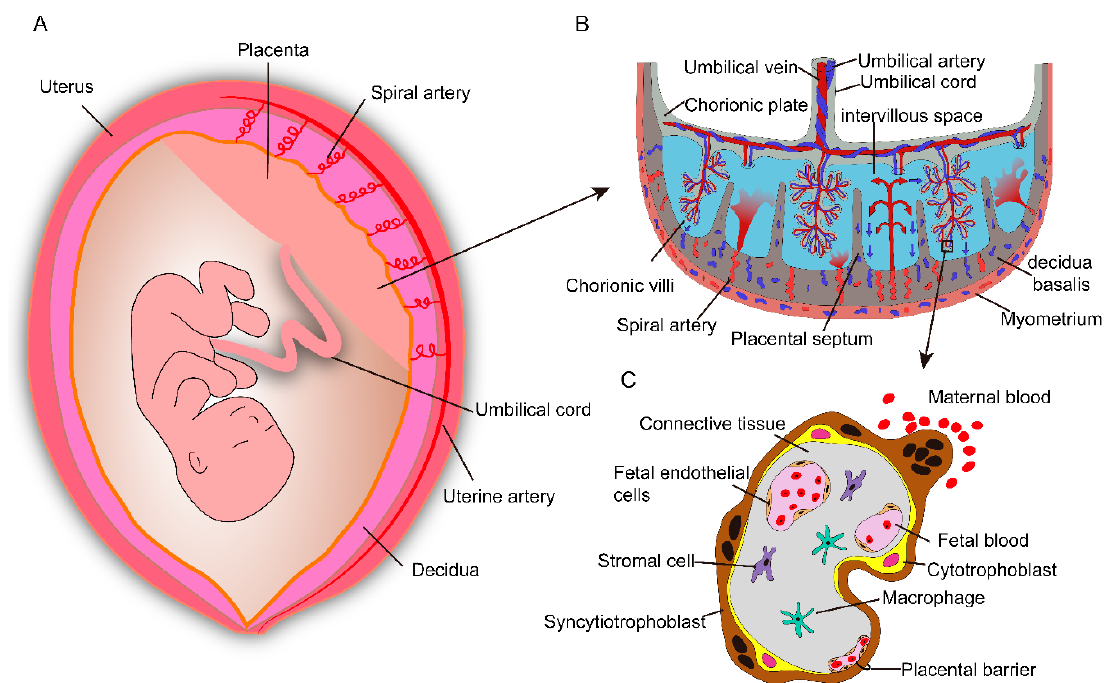
Figure 1. Schematic depiction of anatomical structures of the human placenta. ( A ) The placenta is an important organ for maternal–fetal physiologic exchange and attaches to the uterine wall. ( B ) Anatomical structure and composition of the human placenta. The umbilical vein transport oxygen- and nutrient-rich blood from the placenta to fetus, while two umbilical arteries carry waste products from the fetus to the placenta. The intervillous space is filled with maternal blood, which enters through remodeled spiral arteries. ( C ) The major cell types and the placental barrier, it consists of syncytiotrophoblasts, cytotrophoblasts, and fetal endothelial cells.